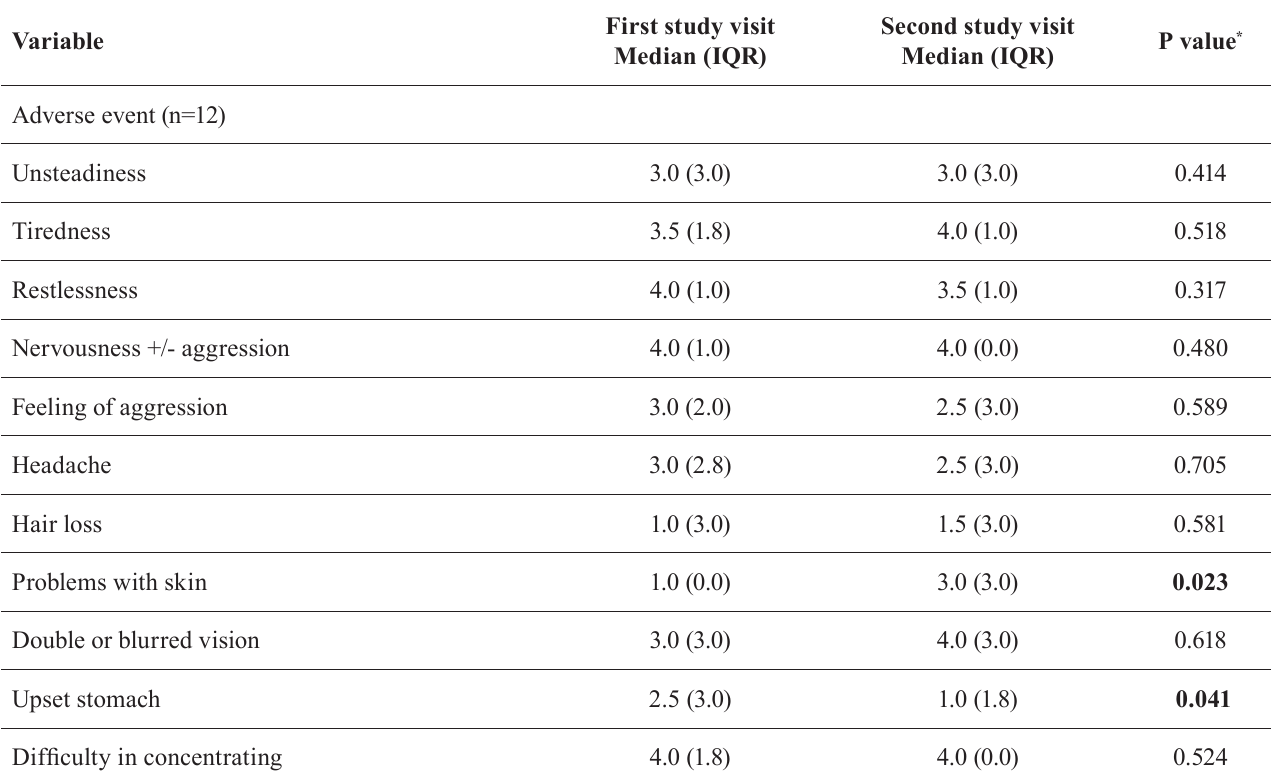
TABLE II - Adverse events profile, quality of life and carbamazepine plasma concentrations before and after the brand/ manufacturer